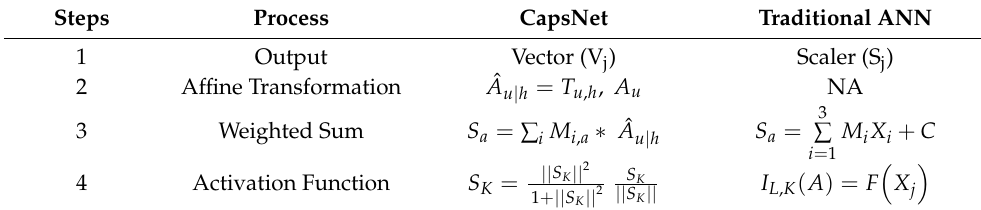
Table 3. Comparison between CapsNet and traditional